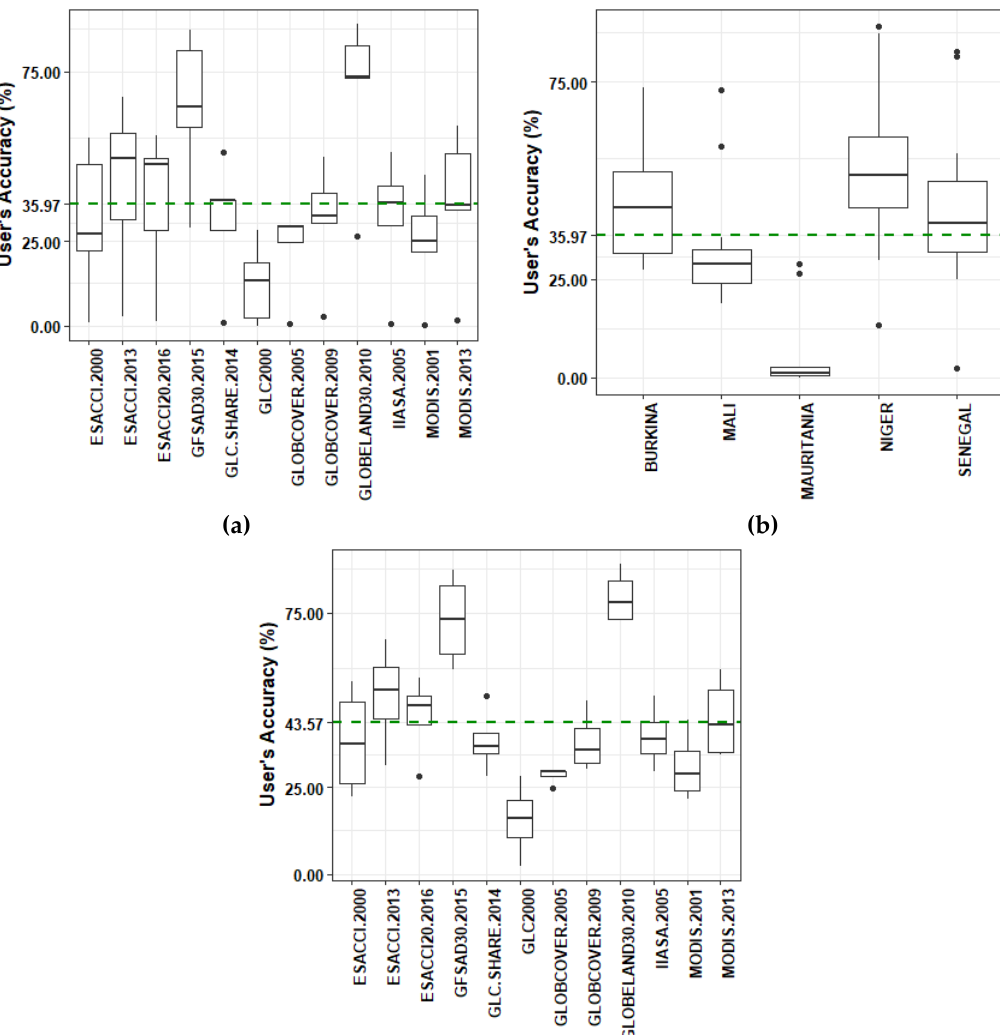
Figure 5. User’s accuracy of crop class for all countries ( a ), all GLC products ( b ), and all GLC products, with Mauritania removed ( c ).